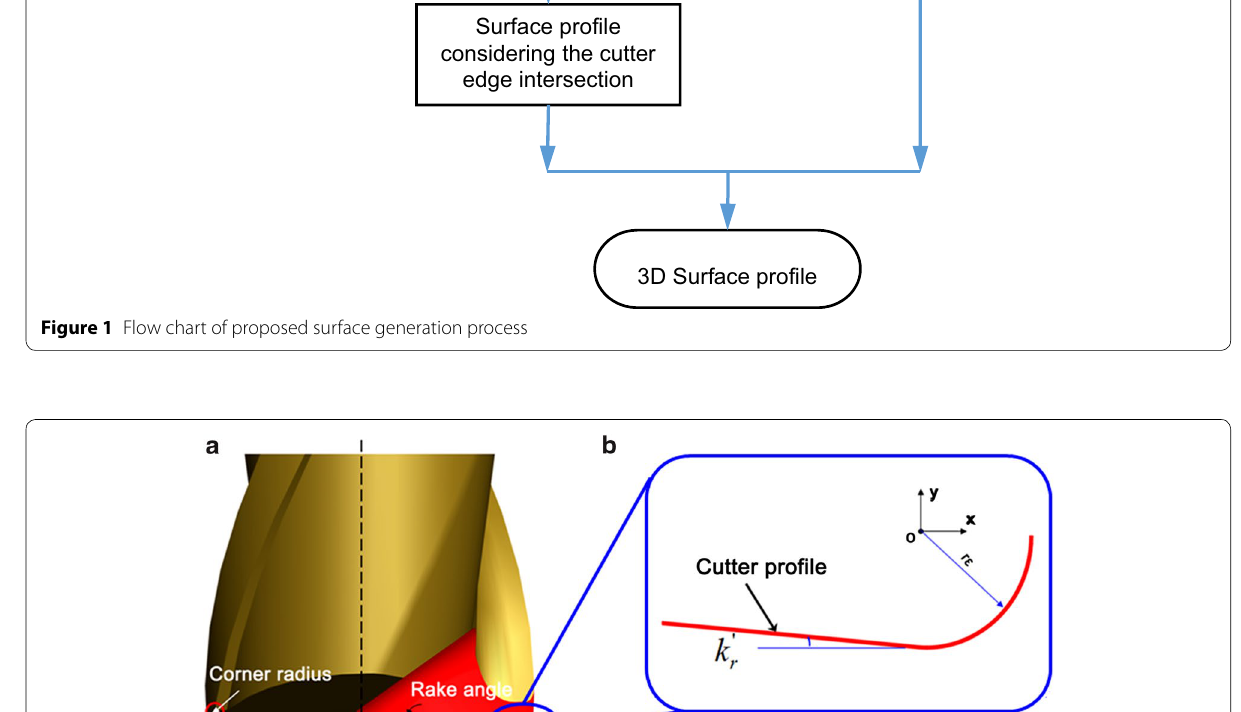
Figure 2 Cutter profile of the micro milling: a Tool geometry model, b the profile of the